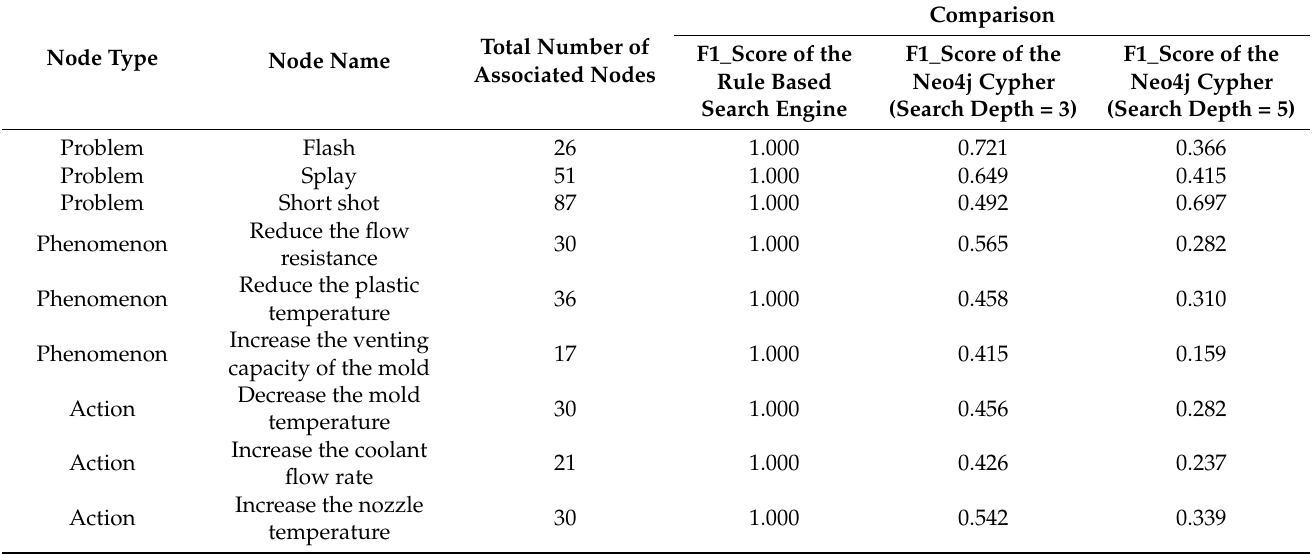
Table 1. Search performance